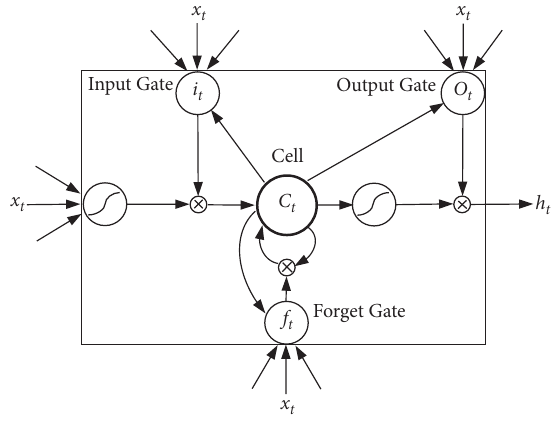
Figure 5: LSTM network